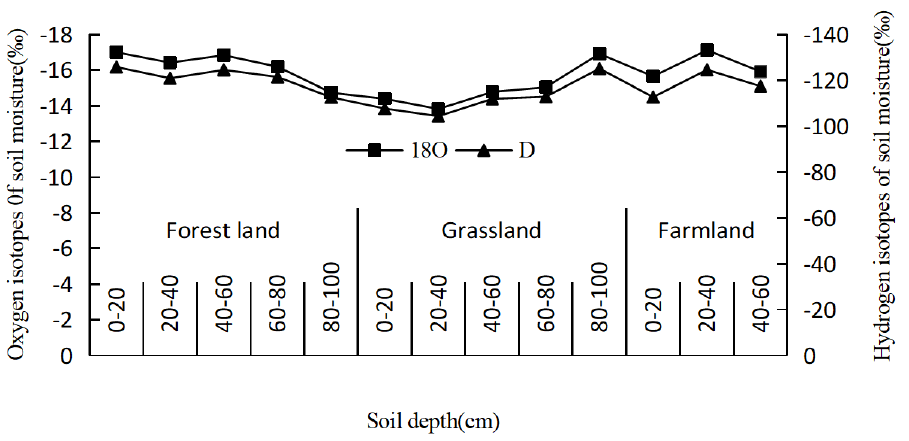
Figure 2: Composition of hydrogen and oxygen isotopes of soil moisture under different land use types and soil